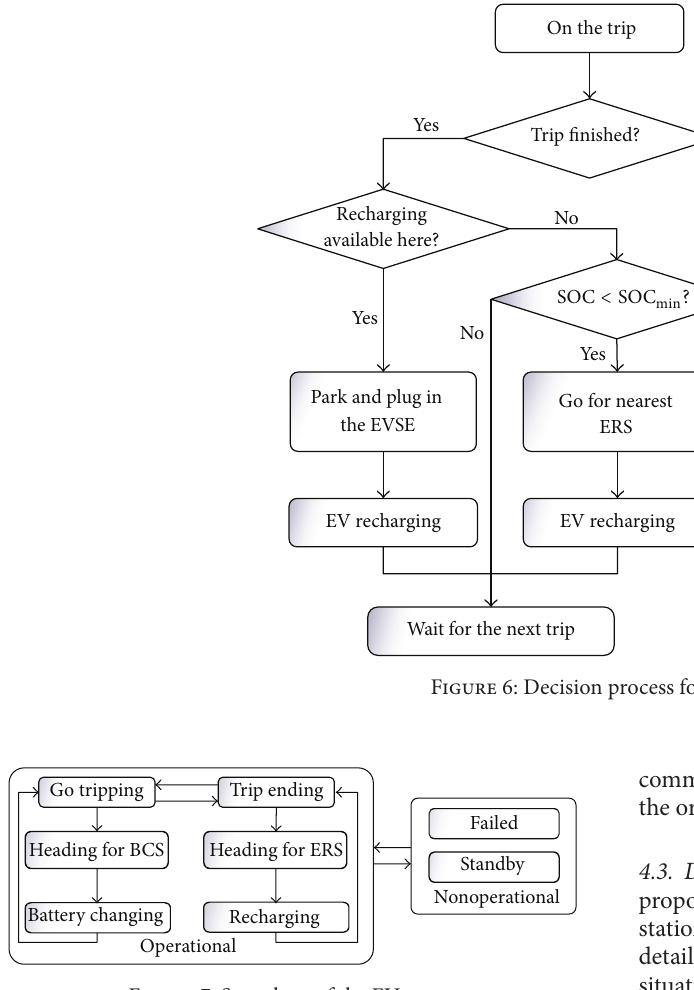
Figure 7: Statechart of the EV